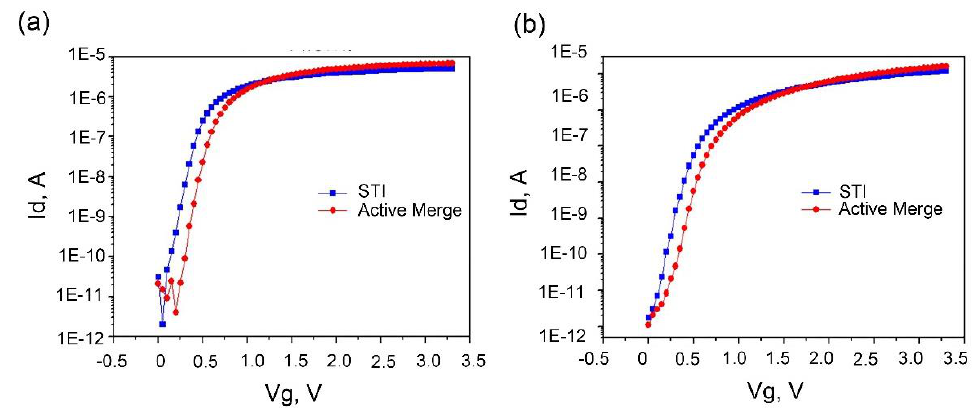
Figure 8. The effect of Merged active area on I d vs. V g curves in a single transistor under ( a ) V d = 0.1 V and ( b ) V d = 3.3 V.